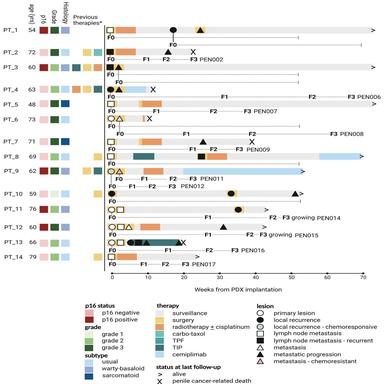
Swimmer plot summarizing the histological characteristics, donor tissue source, and previous and subsequent therapies for all patients from whom tumor samples were included. Successfully established patient-derived xenograft (PDX) models are denoted by PENXXX, where XXX indicates the model number. Time to establishment of first, second, and third generations (F1, F2, F3) is graphically illustrated in weeks. Figure created with Biorender.com. Carbo-taxol = carboplatin and paclitaxel; TPF = docetaxel, cispla